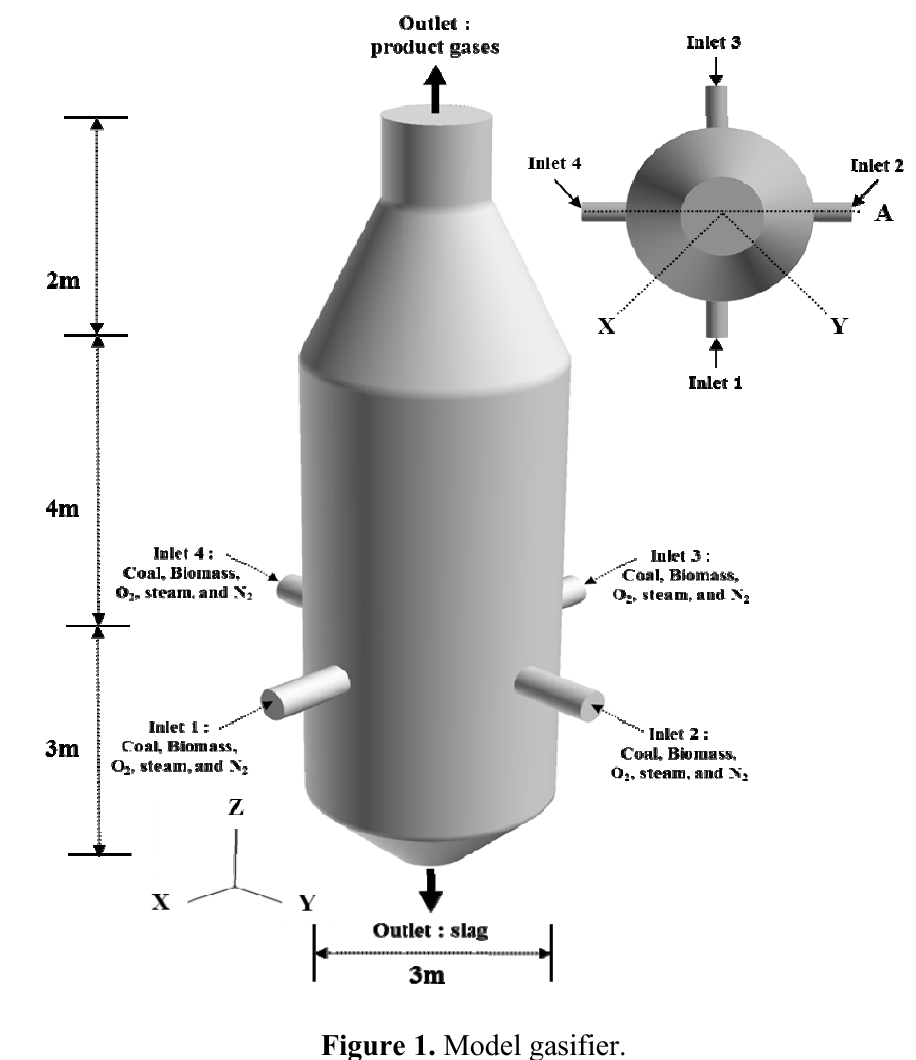
Figure 1. Model gasifier. Table 1. Properties of Illinois #6 coal, Drayton coal, and design coal for the SCGP gasifier in